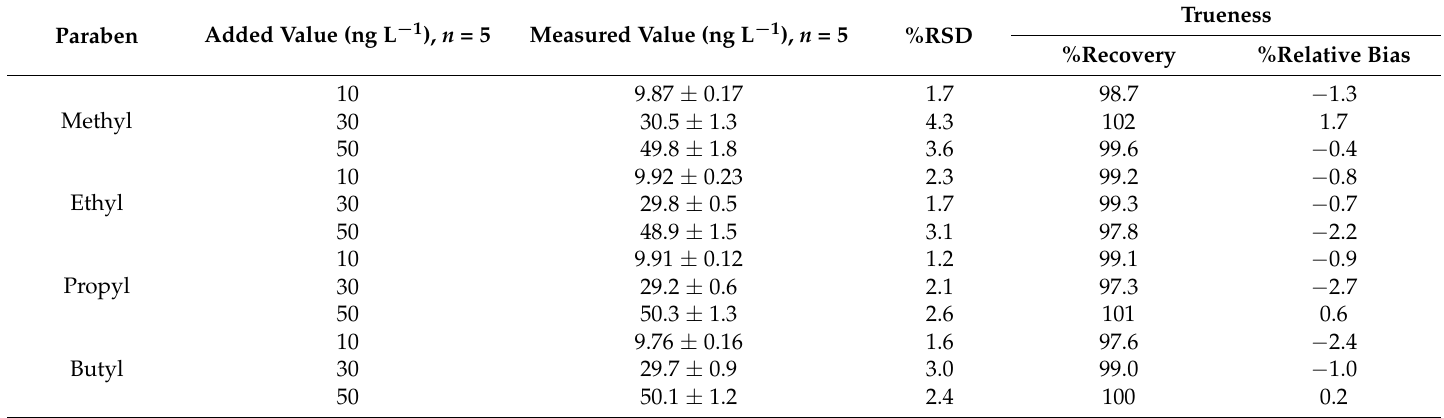
Table 4. Trueness experiment using three level concentrations of each